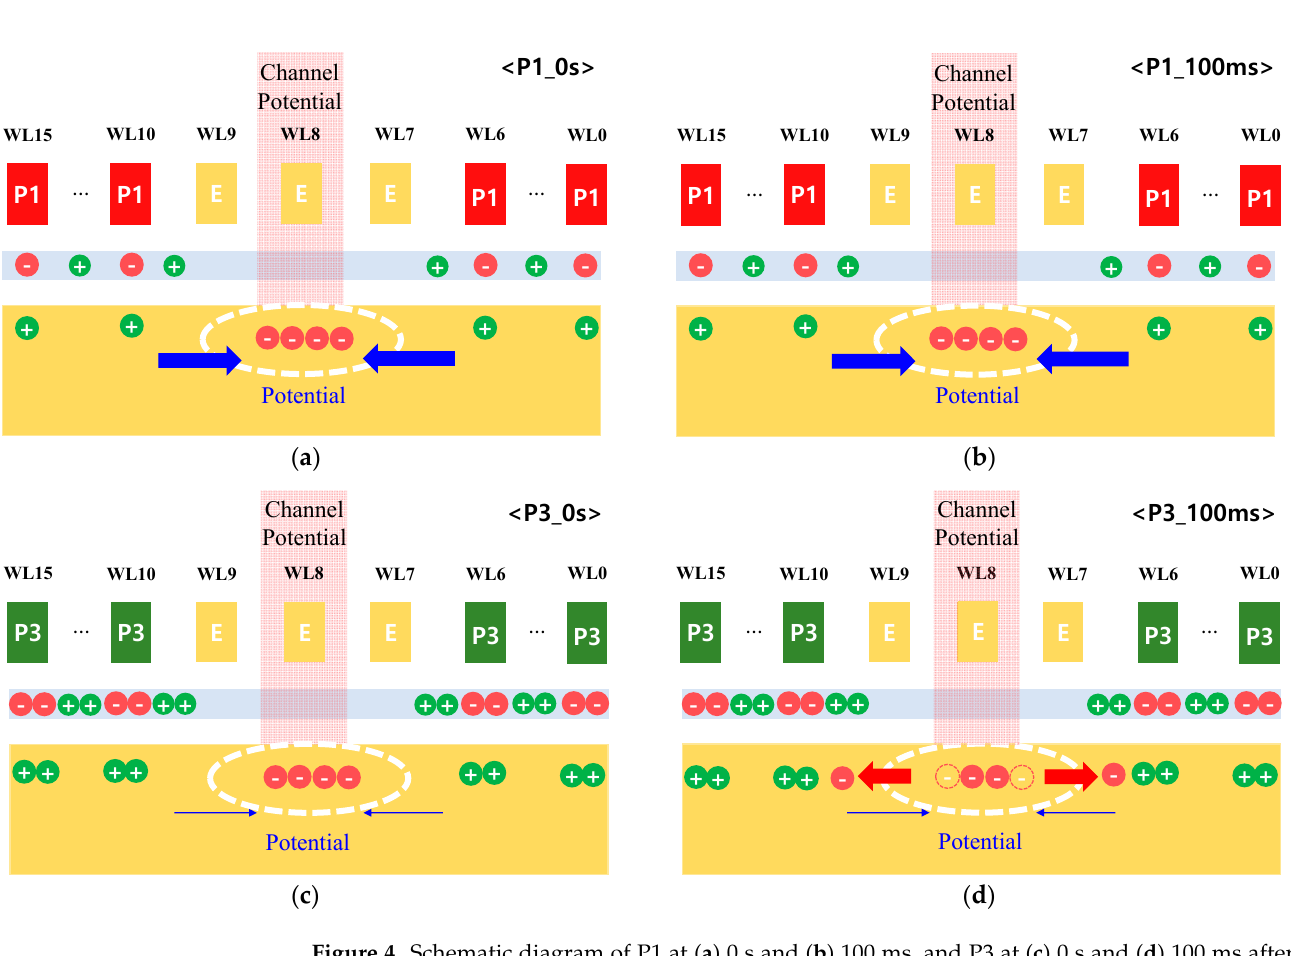
Figure 3. NLSB effect analysis according to transient time ( a ) V th = P1, ( b ) V th = P2, ( c ) V th = P3 and ( d ) is the Δ potential of selected WL at P1, P2, and P3.